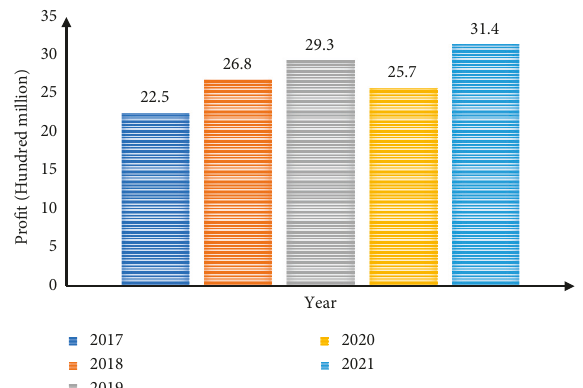
Figure 10: Corporate earnings in nearly five years.